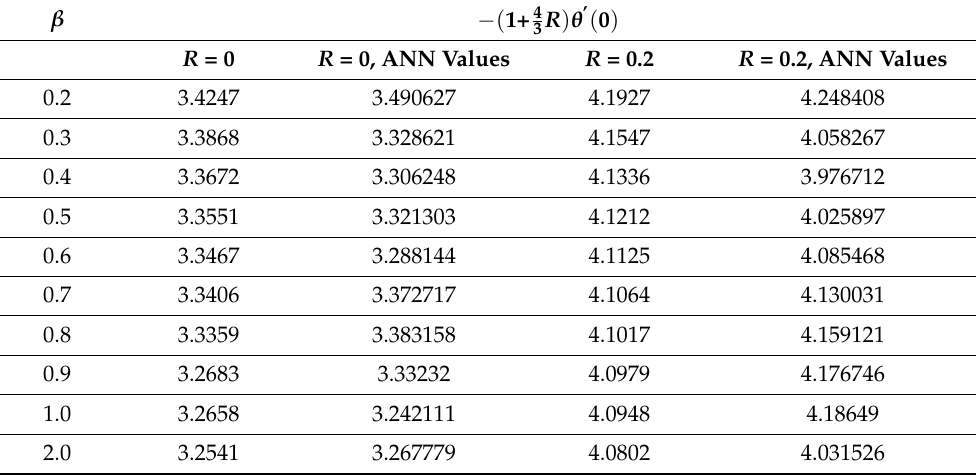
Table 12. Impact of Casson fluid parameter on Nusselt number for radiative and non-radiative flow